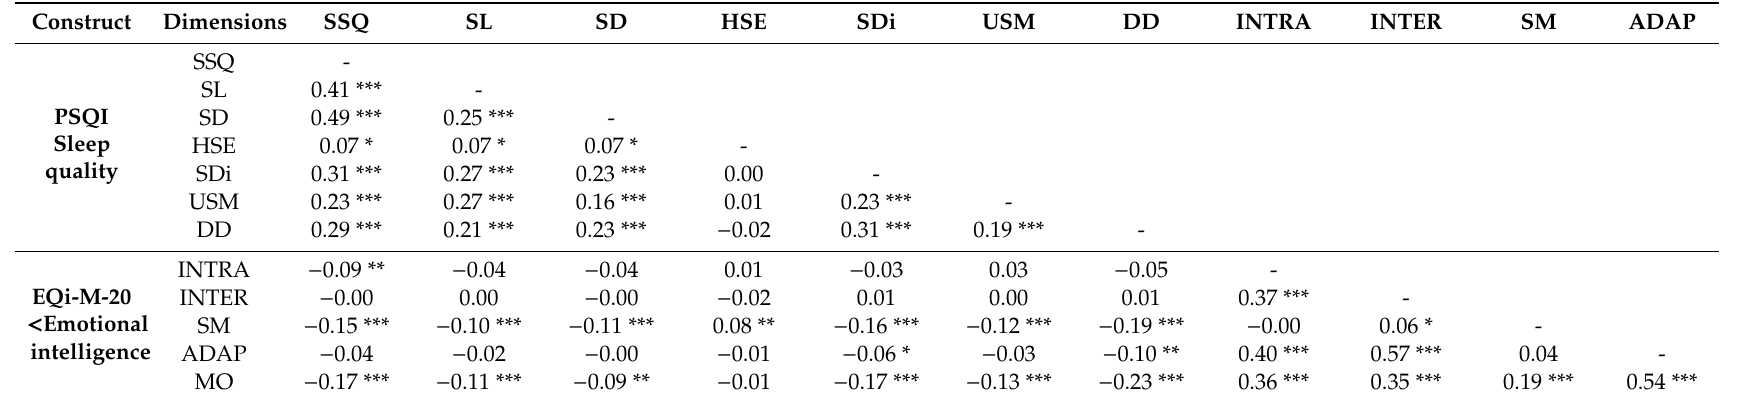
Table 1. Correlations between partial components of sleep quality and emotional intelligence